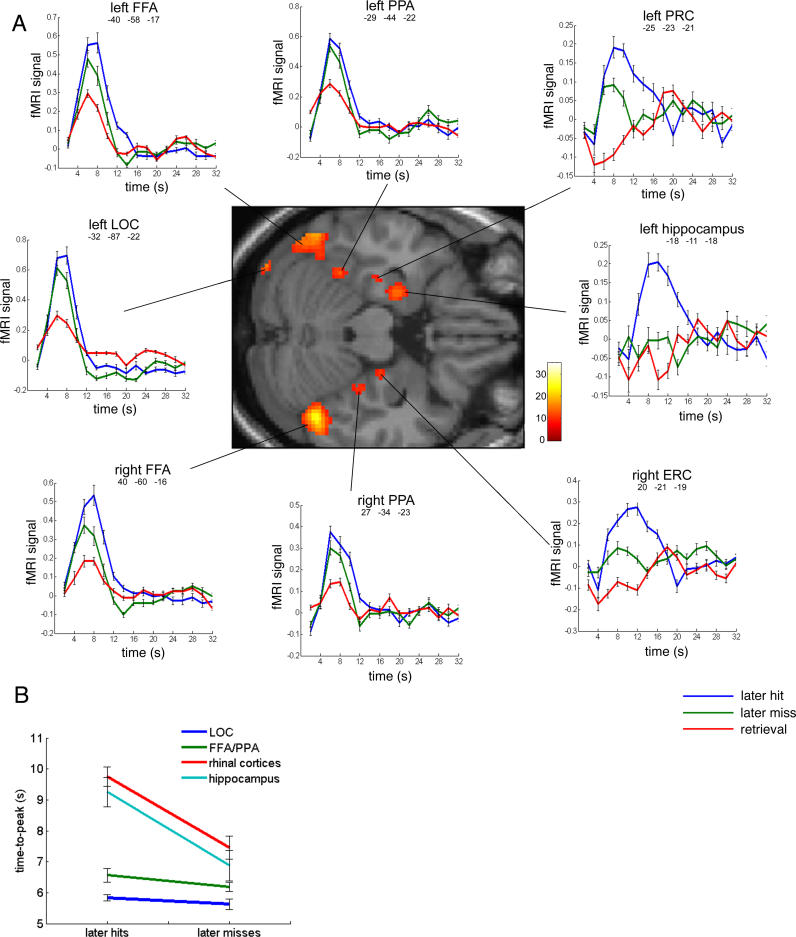
Event-Related fMRI Analyses: Sensory Neocortex and MTL(A) DM effects (voxels for which the response for successfully encoded pairs was greater than that for unsuccessfully encoded pairs) suriving a statistical threshold of
p < 0.001 (uncorrected) are rendered onto a single axial slice of the MNI brain (a single slice was chosen for ease of visualization; voxels shown are not maxima). The scale refers to F values. Each cluster is linked with a black line to a plot of the HRFs for later hits (blue), later misses (green), and unsorted retrieval trials (red). HRFs are averaged across participants; bars are standard errors. Lineplots are titled with the name of the relevant brain region. ERC, entorhinal cortex; PRC, perirhinal cortex. Subtitles indicate the Talairach coordinates of the peak voxel for each significant cluster.
(B) Time-to-peak estimates of the HRF for LOC (blue), FFA/PPA (green), rhinal cortices (red), and hippocampal (cyan) ROIs in each subsequent memory condition. Time-to-peak on the
y-axis is in seconds.